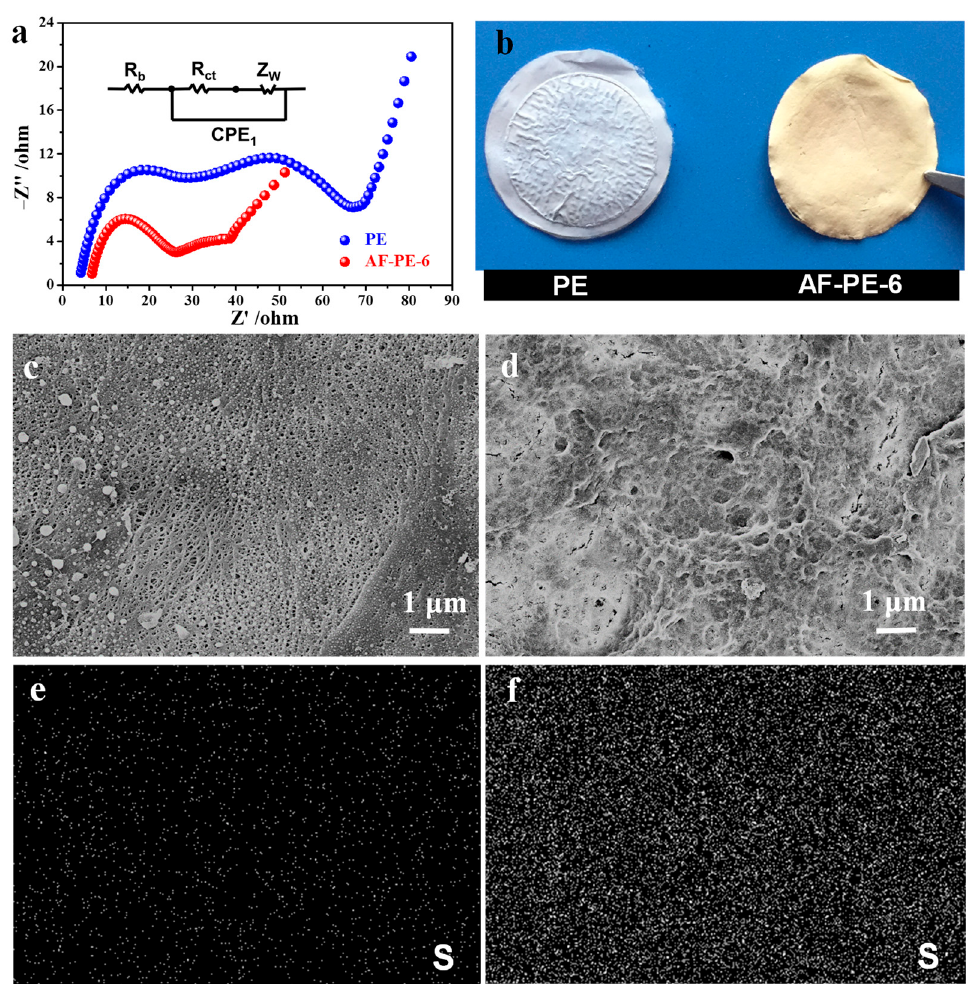
Figure 5. ( a ) Nyquist plots and ( b ) the optical images of pristine PE film and AF-PE-6 film after 200 cycles. SEM images of ( c ) pristine PE and ( d ) AF-PE-6 films after 200 cycles. Elemental mapping of S of ( e ) pristine PE and ( f ) AF-PE-6 films after 200 cycles.